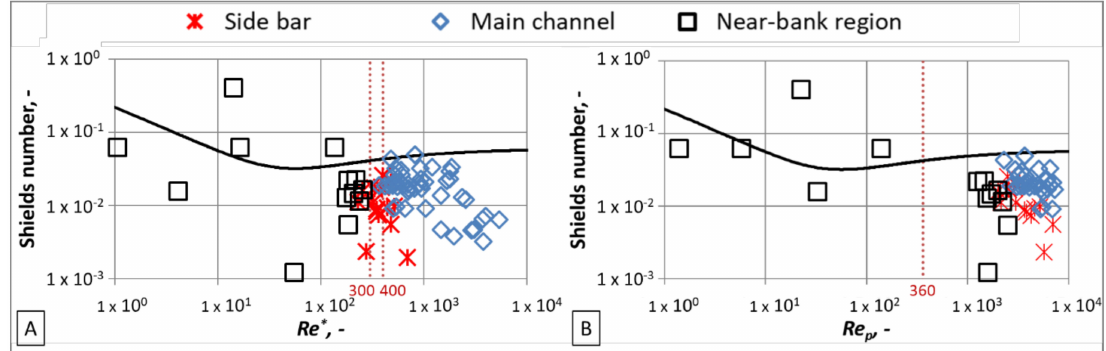
Figure 6. ( A ) Shields number as the function of the shear Reynolds number, based on laboratory and field data [17,59,64]. Shields curve is indicated with black line. ( B ) Shields number as the function of the explicit particle Reynolds number, based on laboratory and field data [17,59,64]. Shields curve is indicated with black